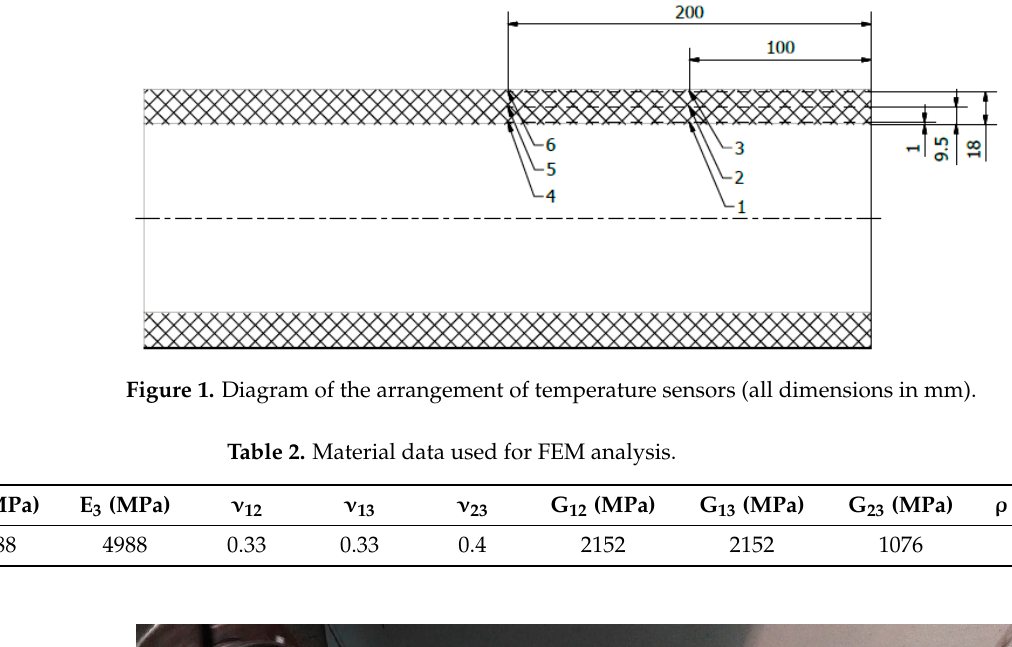
Table 2. Material data used for FEM analysis.